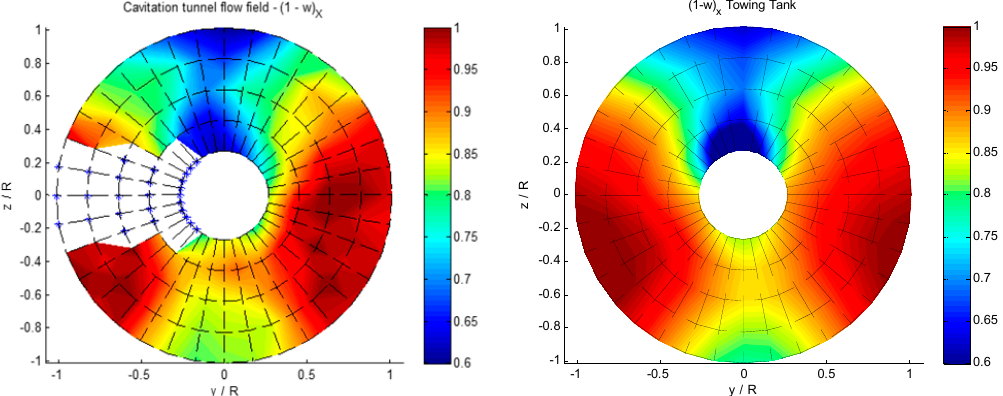
Figure 12. Nominal wake field: Simulated in cavitation tunnel ( Left ); Measured at towing tank ( Right ).